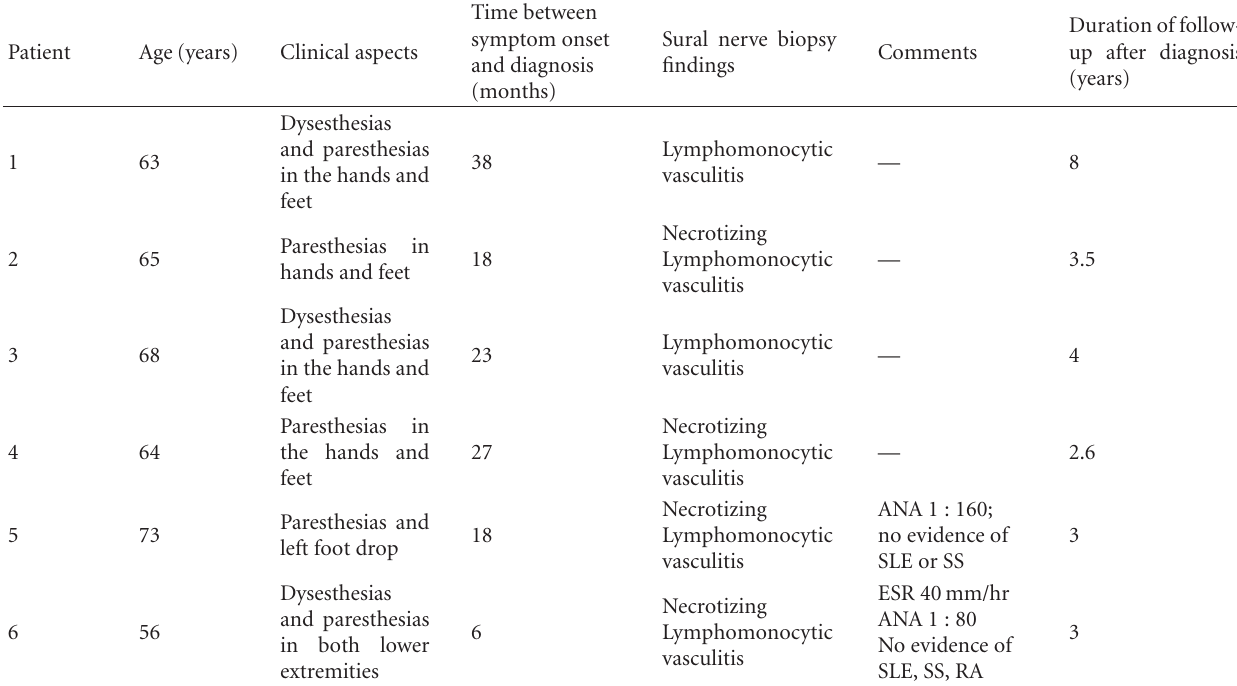
Table 1: Idiopathic vasculitis strictly a ff ecting the peripheral